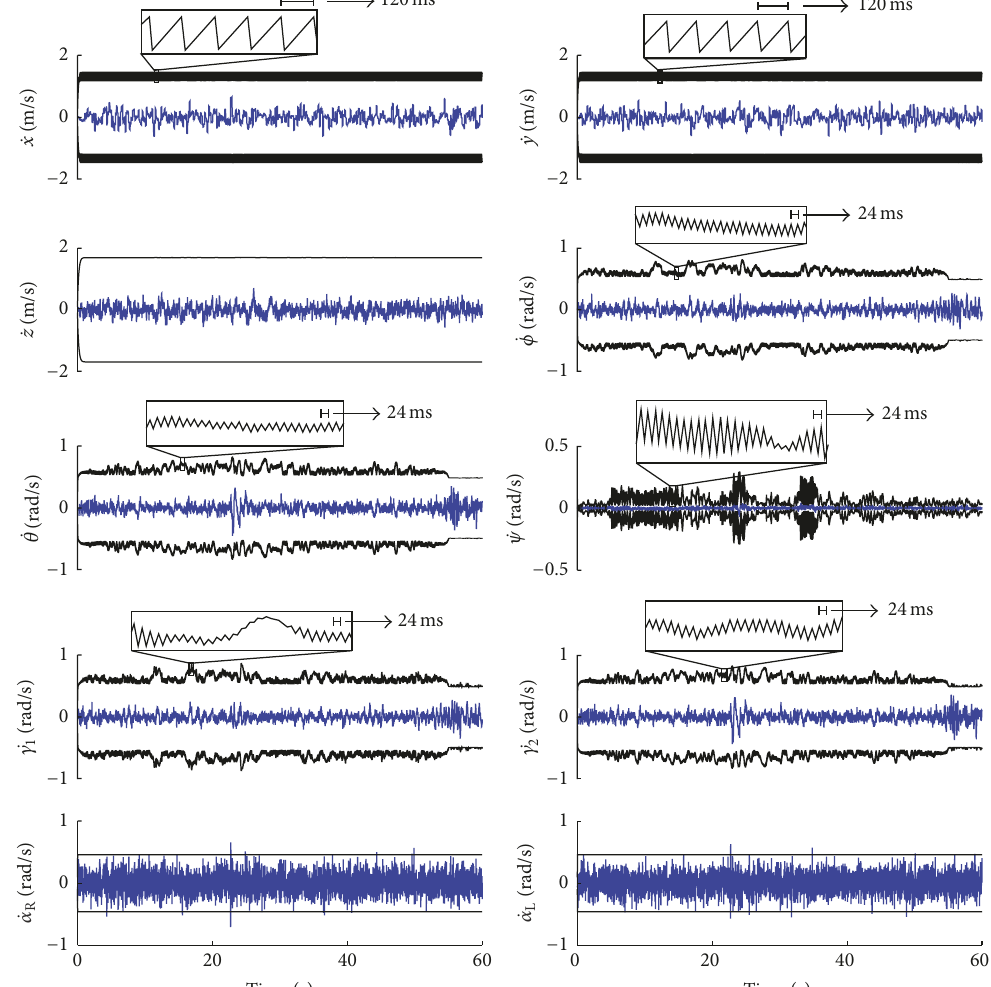
Figure 13: Time evolution of the estimation error of the generalized coordinates derivatives, along with the confidence limits. Patterns are highlighted to illustrate the estimation behavior in presence of different sampling